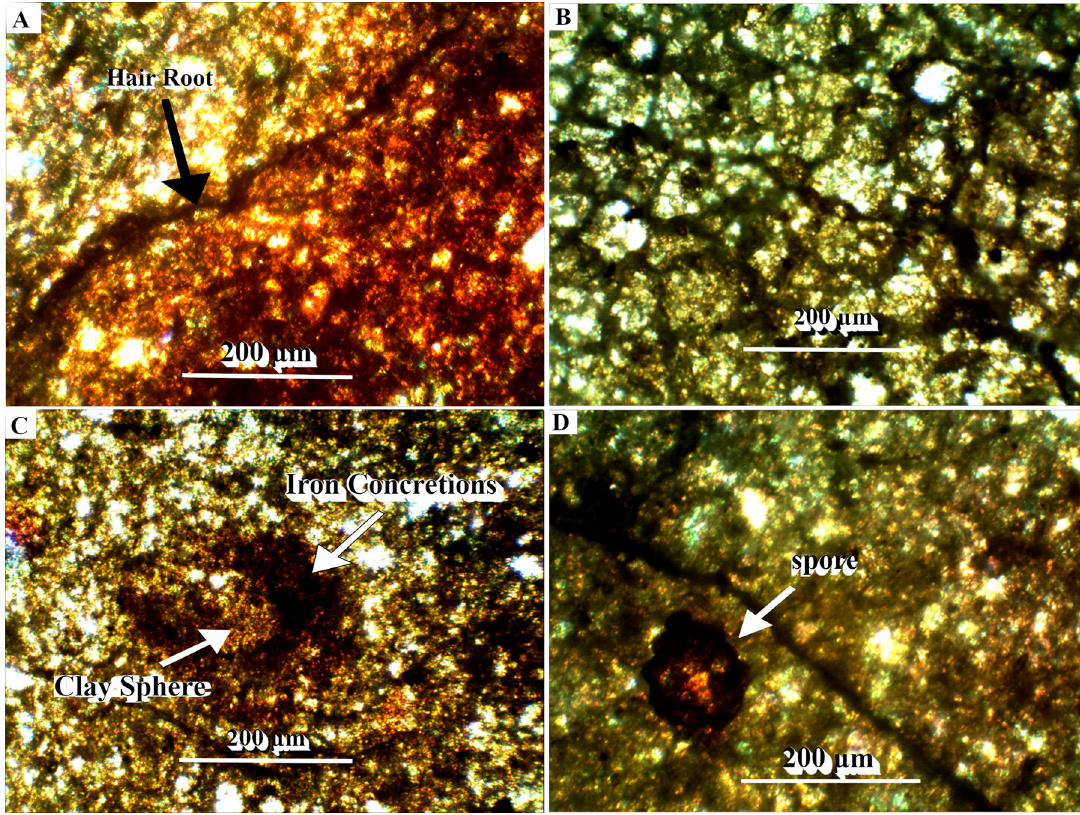
Fig 7. Photomicrograph from the fine root areas along the C-D section. (A) A fine root working as a borderline between oxidized and reduced sediments. (B). The network of dense fine roots. (C) An iron concretion formed around a spherical clay. (D) A Spore along a fine